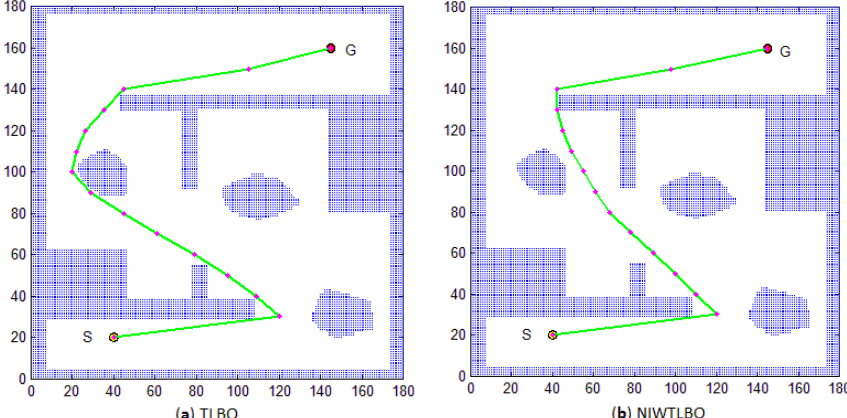
Figure 6. Path planning in the scenario of complex2. D = 13. ( a ) The result of the TLBO; ( b ) The result of the NIWTLBO. Information 2016 , 7 , 39